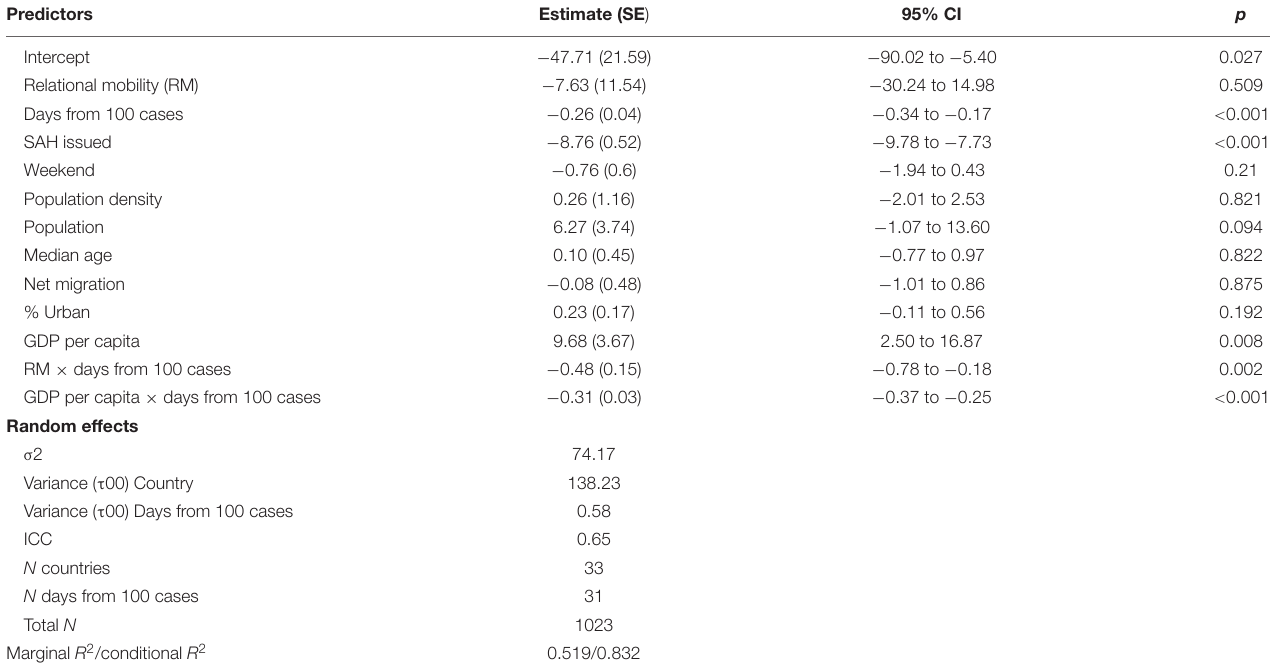
TABLE 3 | The impact of relational mobility and GDP per capita on geographic mobility after first 100 cases of COVID-19 in a given country. Predictors Estimate (SE )